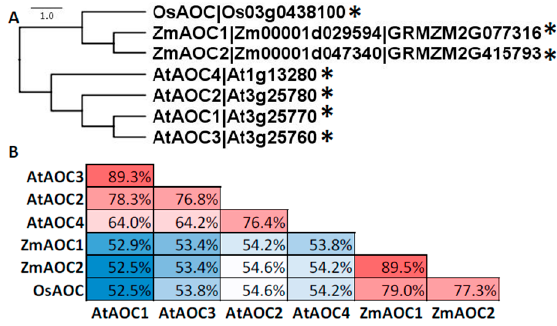
Figure 7. Amino acid sequences of AOC family members from Arabidopsis , maize, and rice compared with ClustalX and visualized with Figtree. ( A ) Gene labels follow nomenclature from Arabidopsis [84], maize (this chapter), and rice [72]. * denotes predicted CTP by ChloroP. ( B ) Identity analyses was performed with SIAS. The color code (red to white to blue) scale represents the percent sequence identity from greatest to least.